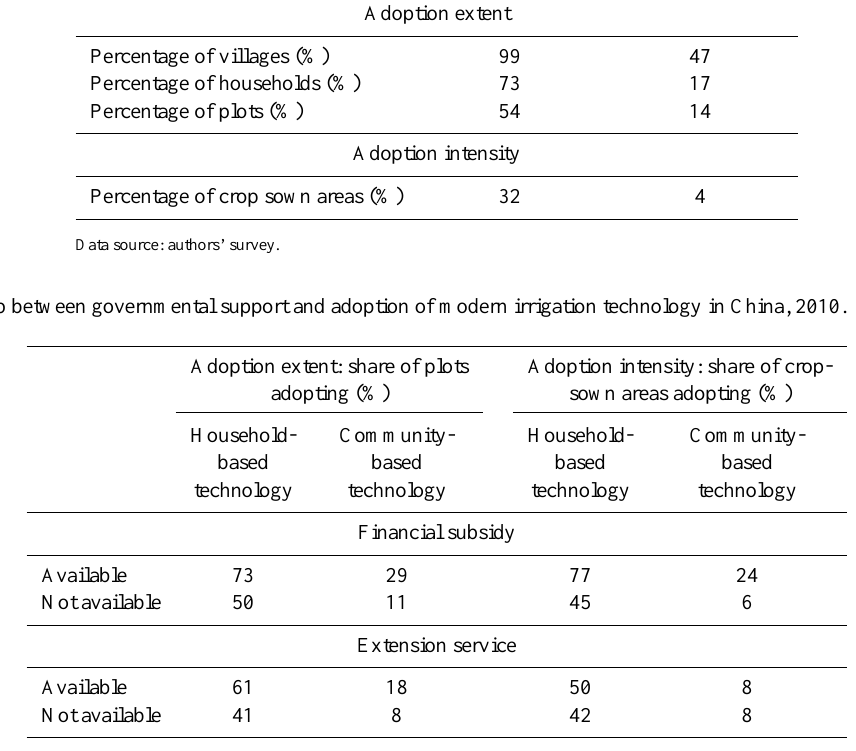
Household-based